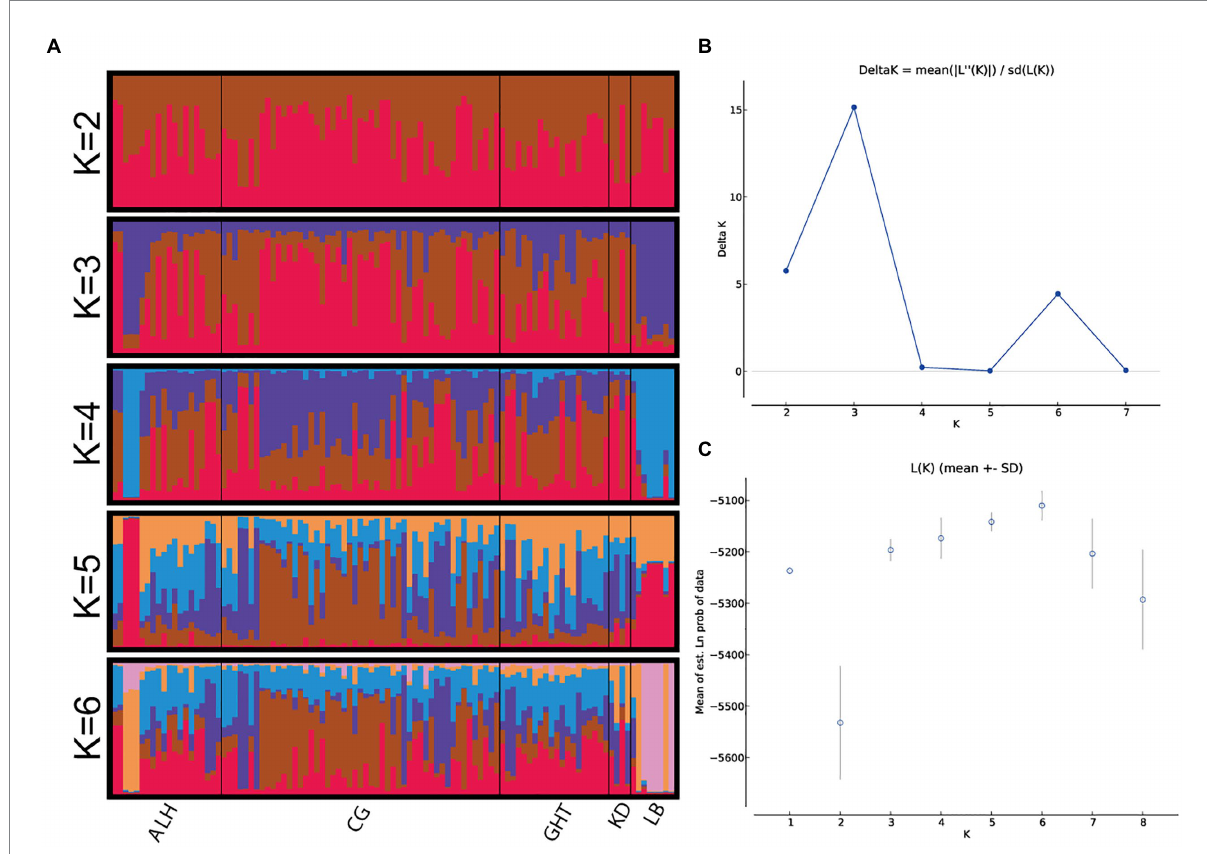
FIGURE 3 Bayesian STRUCTURE clustering results for Jankowski’s Bunting based on 15 microsatellite loci. (A) STRUCTURE output of different genetic clusters identified (showed only K = 2–6). The proportions of ancestry assigned to different clusters were plotted by individuals. Each column (representing the individual) is divided into K segments of different colors, whose length is proportional to its membership in the corresponding genetic cluster. (B) Inference of optimum K value. Changes in the log-likelihood, Δ K , for the different numbers of groups. (C) log-likelihood,